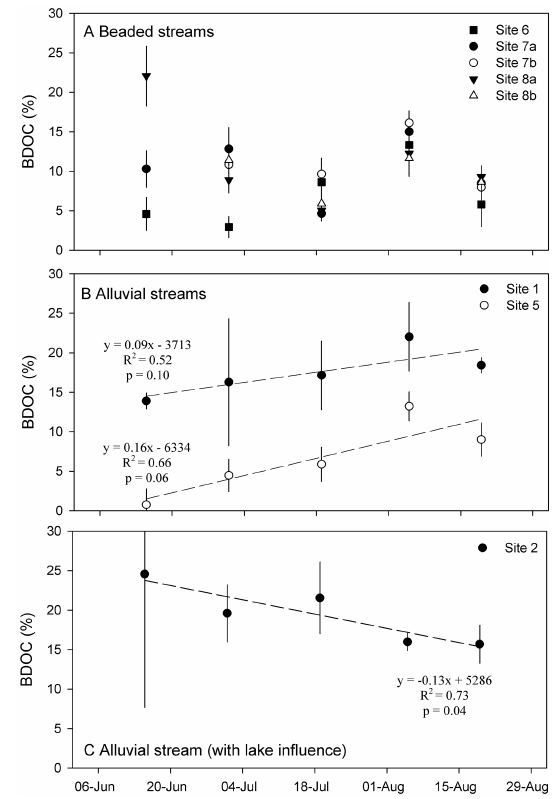
Figure 5. Seasonal trends in BDOC (%): (a) beaded stream sites – no significant trends; (b) alluvial sites without any lake influence – significantly increasing trends; (c) alluvial site with lake influence upstream – significantly decreasing trend. Each symbol and associ- ated error bars represent the mean BDOC (%) and the standard error of the four field